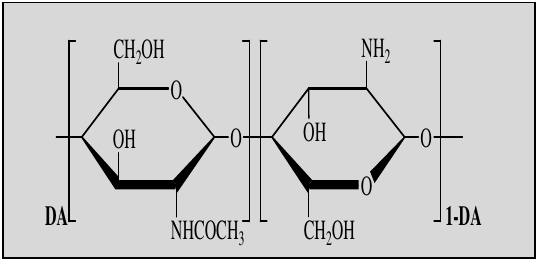
Fig. 1. Chemical structure of